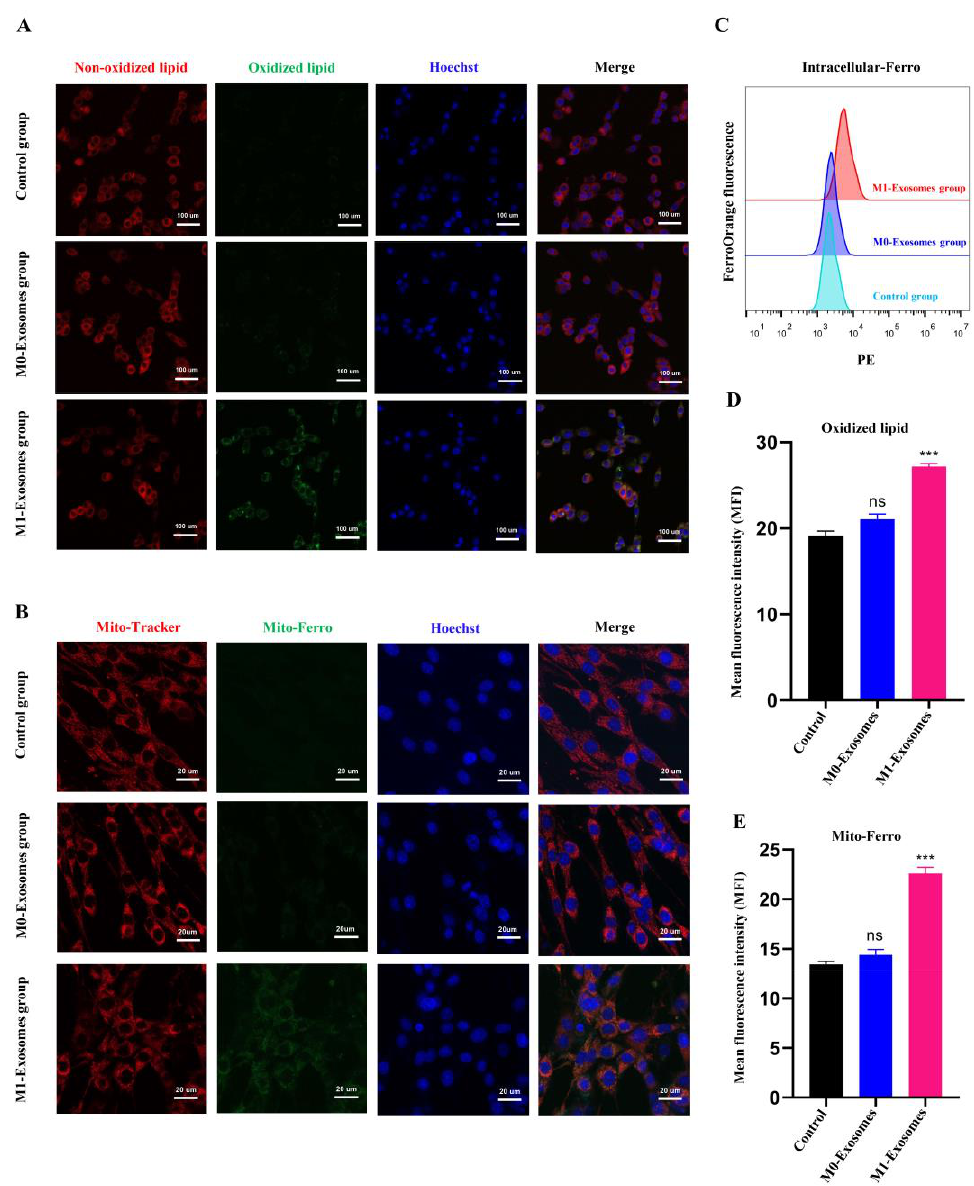
Figure 6. Levels of lipid peroxidation and mitochondrial and intracellular ferrous iron in neuronal cells following different treatments. ( A ) Representative fluorescent images of lipid peroxidation of neuronal cells after staining with C11BODIPY 581/591. Green represents oxidized lipid, red represents nonoxidized lipid, and blue represents Hoechst-stained nuclei. Scale bars = 100 µ m. ( B ) Representative fluorescent images of mitochondrial ferrous iron obtained using Mito-Tracker (Red), Mito-Ferro (Green), and Hoechst (blue). Scale bars = 20 µ m. ( C ) The intracellular ferrous iron level was determined using FerroOrange (PE fluorescence) with flow cytometry analysis. ( D , E ) Statistical results of lipid peroxidation and mitochondrial ferrous iron levels in neuronal cells (ns p > 0.05, *** p < 0.001). Data are presented as the mean ± SD of three independent